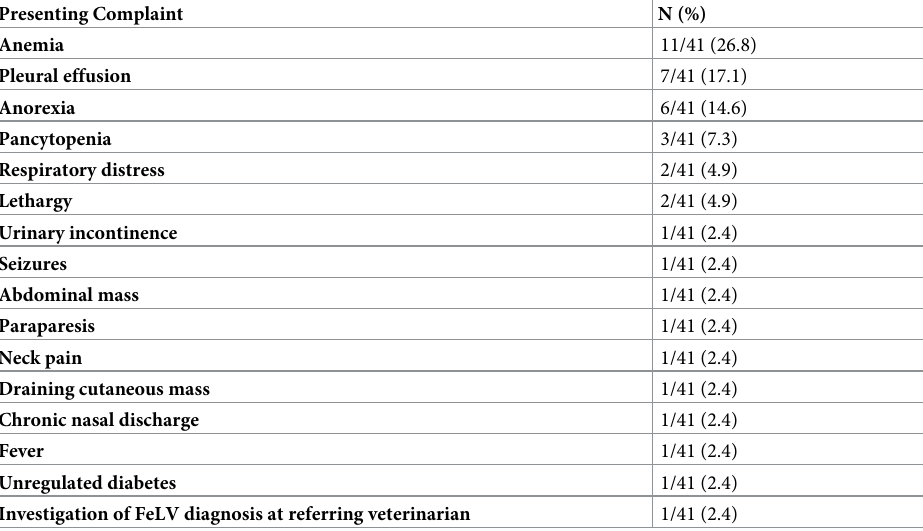
Table 1. Presenting complaints of FeLV-positive